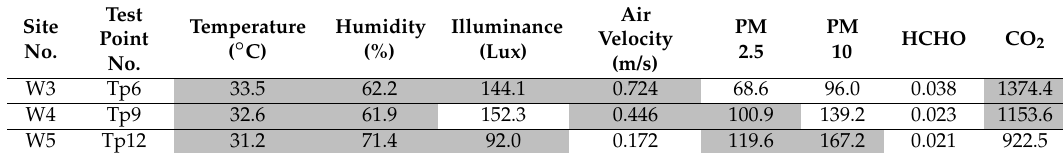
Table 8. Average values of the physical test results from the station hall.